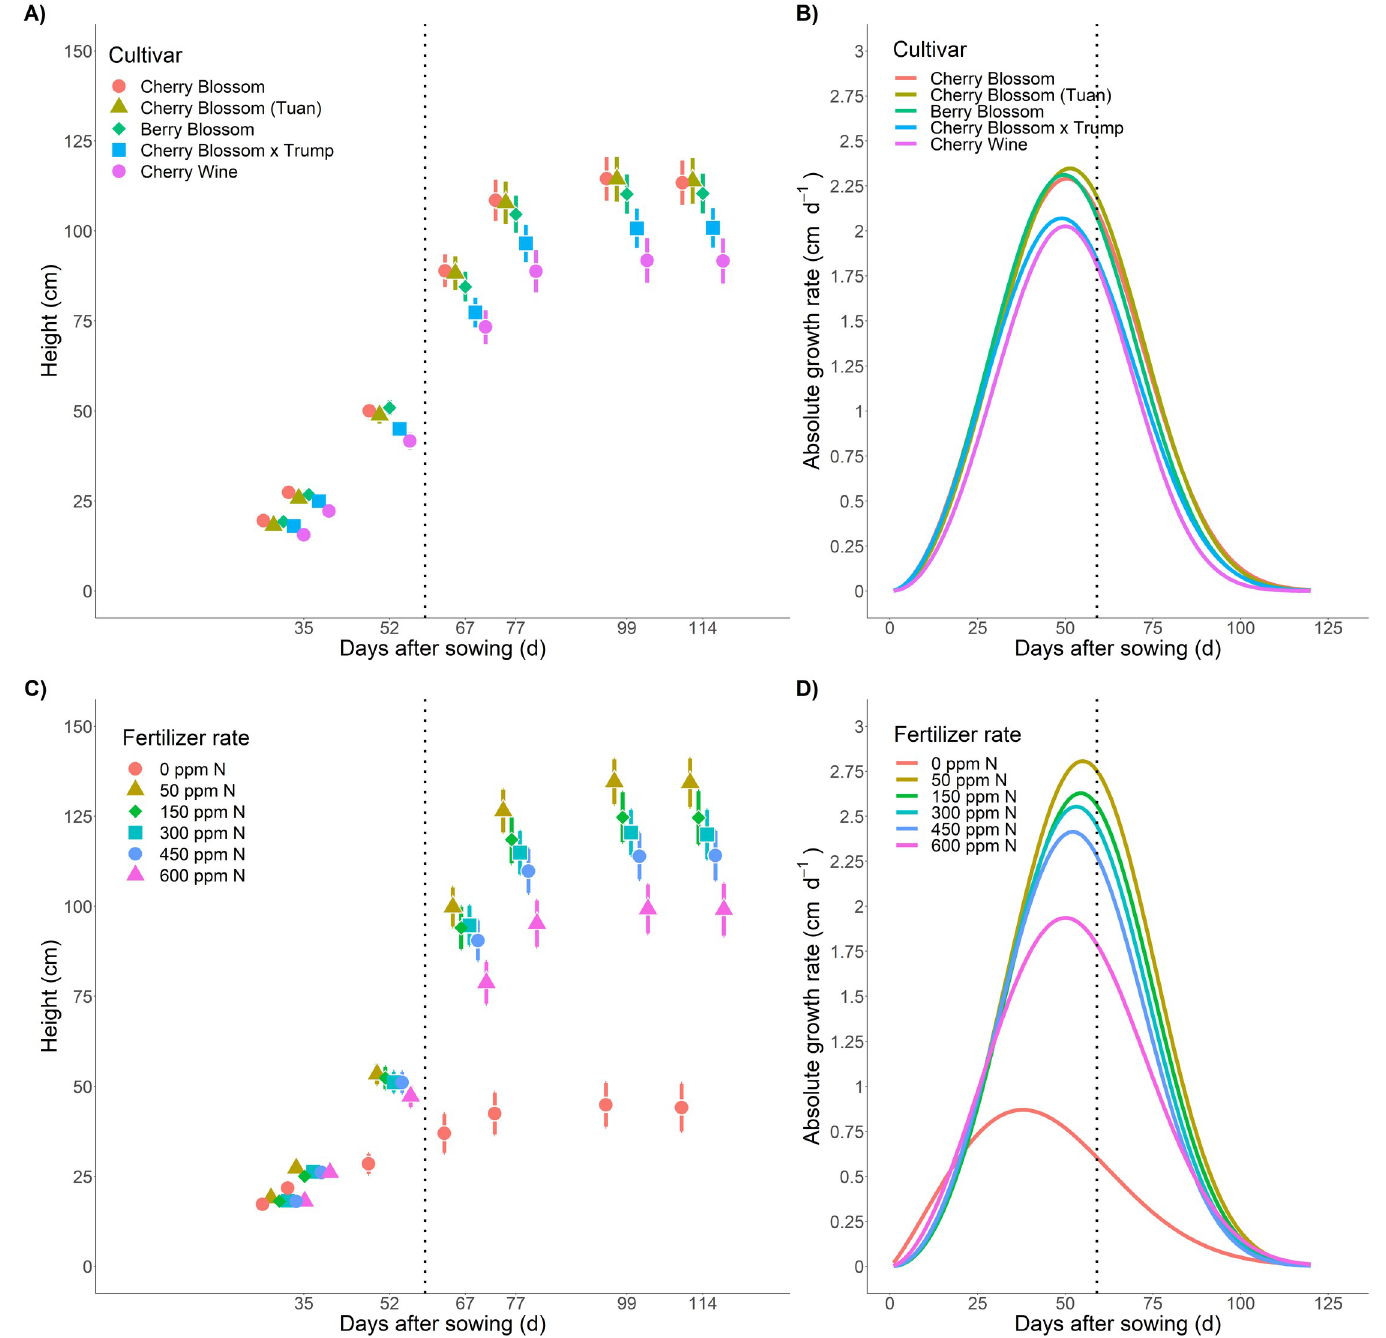
Fig 3. [A] Temporal plant heights BLUEs by cultivar. Error bars depict 95% confidence intervals. [B] Growth rate curves by cultivar. [C] Temporal plant heights BLUEs by fertilizer treatment. Error bars depict 95% confidence intervals. [D] Growth rate curves by fertilizer treatment. Vertical black dashed lines indicated vegetative to floral transition. Connecting letter reports can be accessed in S4 and S5